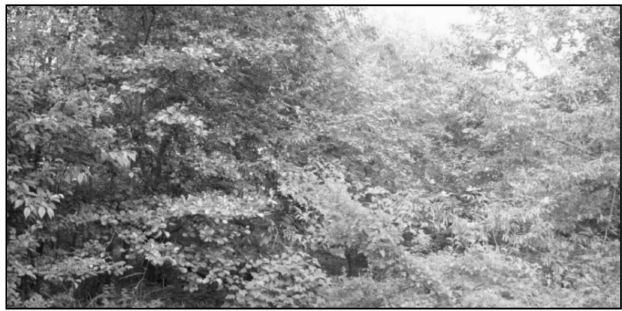
Figure 11. Deciduous forest clearing with undergrowth (photo by Arvydas